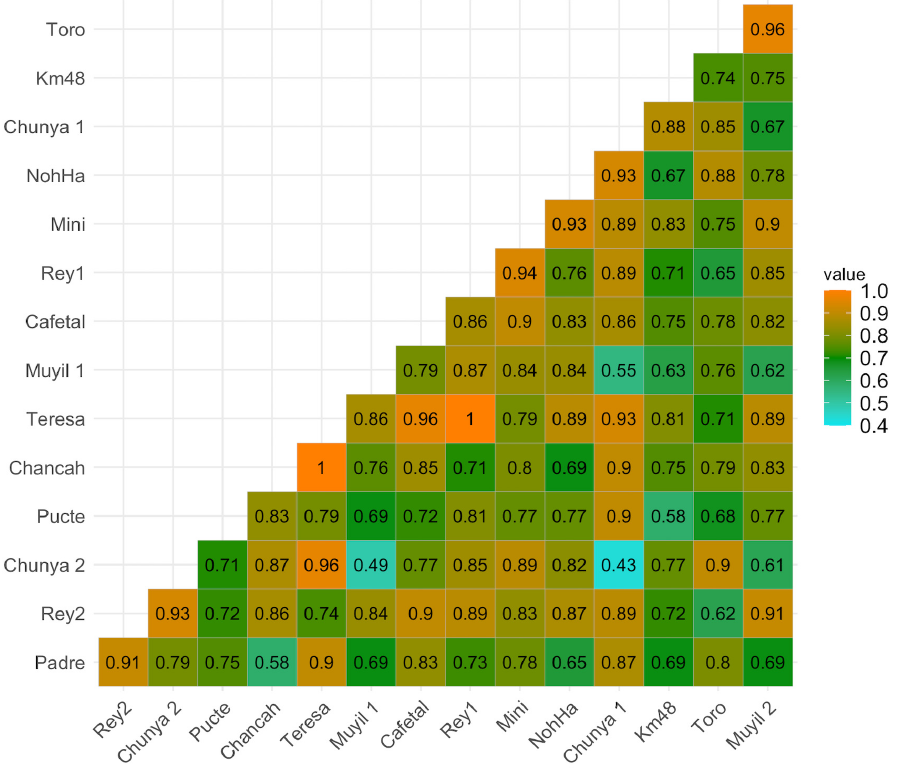
Figure 8. Sorensen dissimilarities among sampling aquatic systems. Abbreviations are the same as Figure 7.